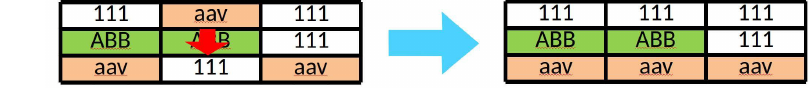
Figure 4. First neighborhood example.